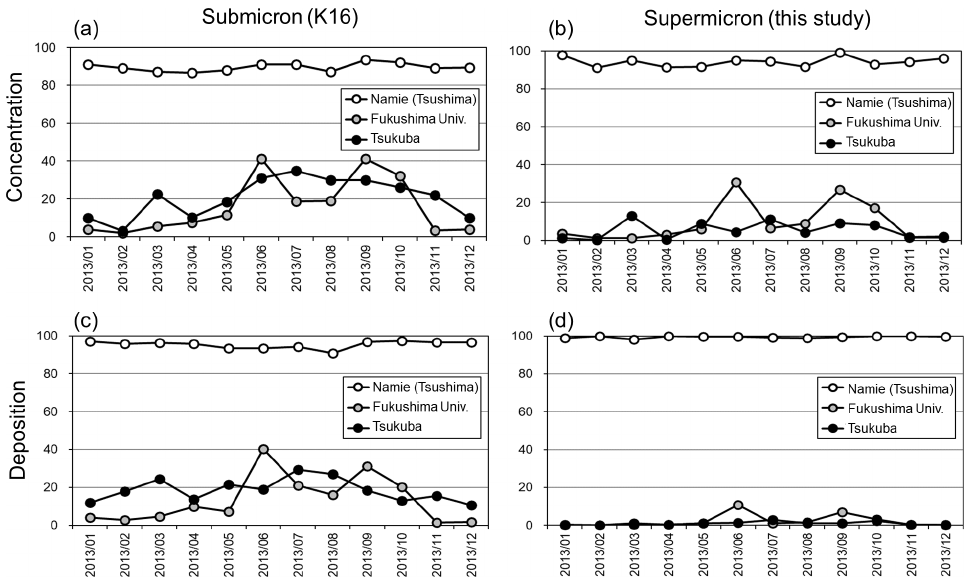
Figure 6. Monthly mean fractional contributions from the resuspension source area (defined as initial depositions of 137 Cs exceeding 300kBqm − 2 ) to the (a, b) surface concentrations and (c, d) deposition amounts assuming (a, c) submicron (K16; E c and v d are 0.04 and 0.1cms − 1 , respectively) and (b, d) supermicron (this study; E c and v d are 0.4 and 10cms − 1 , respectively) sizes of 137 Cs-bearing particles at Namie (Tsushima), Fukushima, and